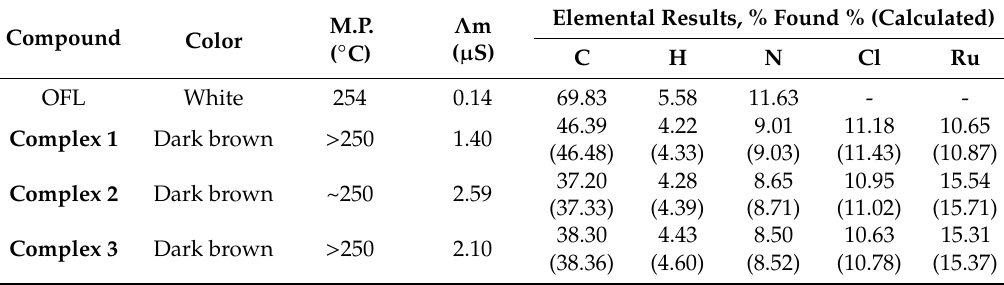
Figure 3. Proposed chemical structures of the Ru(III)-OFL complexes. Table 1. Microanalytical and physical values of free OFL and the Ru(III) complexes.